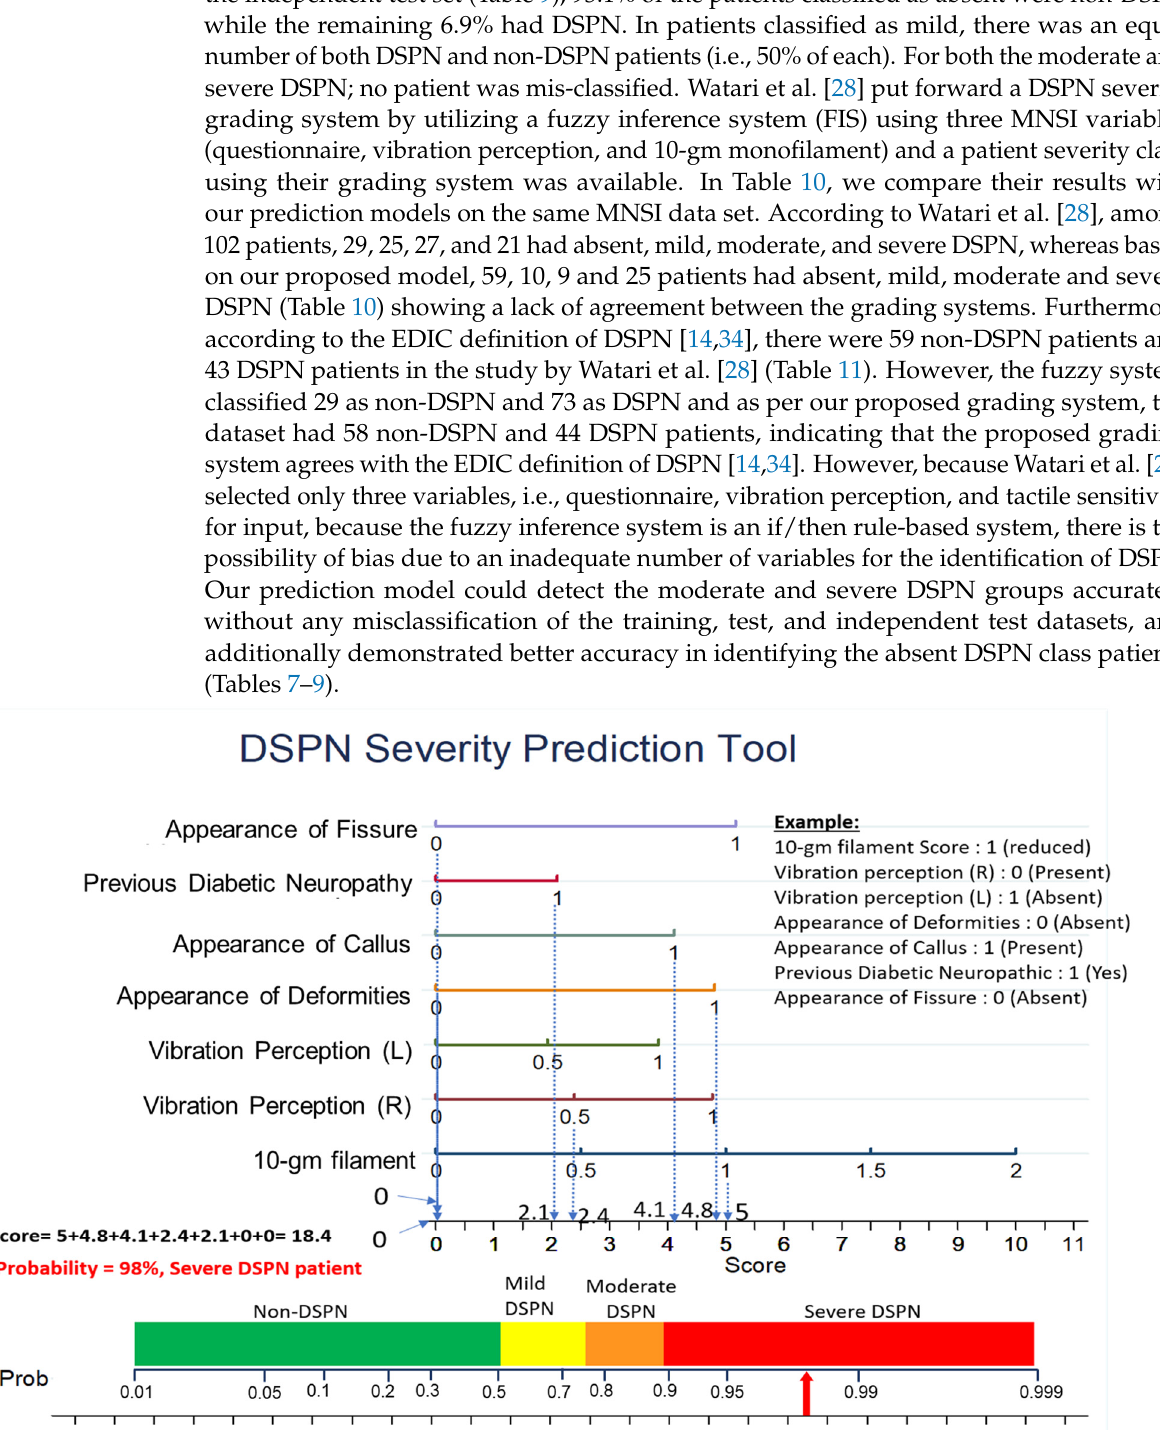
Figure 6. Example nomogram-based score for the probability prediction of DSPN severity.